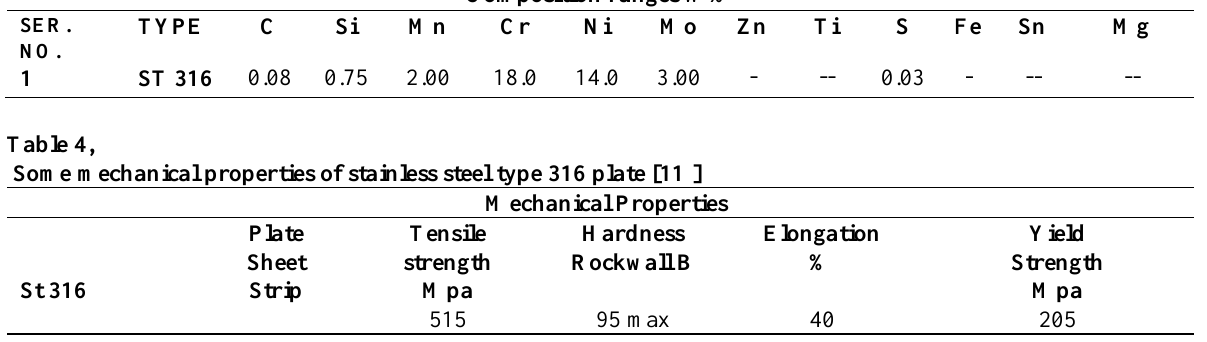
Composition ranges W%